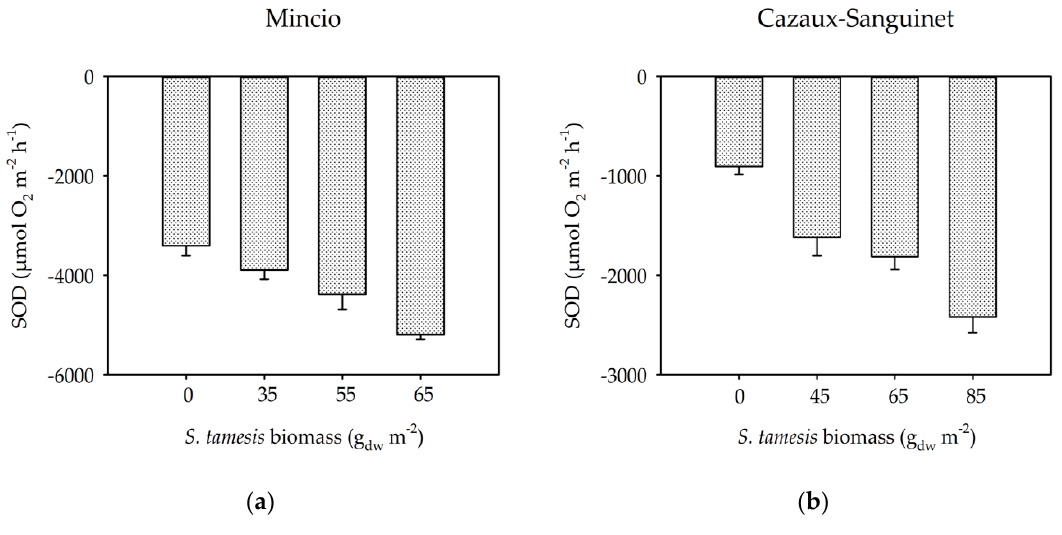
Figure 1. Sediment oxygen demand in the four treatments in the Mincio River ( a ) and in the Cazaux-Sanguinet Lake ( b ). Averages ± standard errors are reported. Note different scales on y -axis.